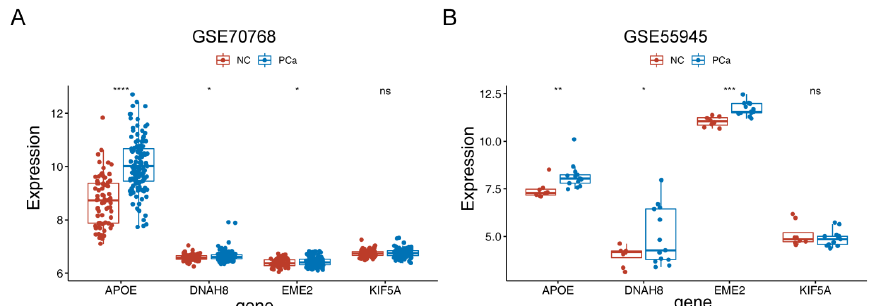
Figure 6. Validation the expression levels of four model genes in the GSE70768 and GSE55945 datasets. ( A ) The expression levels of the four model genes in the GSE70768 dataset. ( B ) The expression levels of the four model genes in the GSE55945 dataset. * p < 0.05, ** p < 0.01, *** p < 0.001, **** p < 0.0001, ns represents no significant difference. 3.8. Validating the Expression of the Four Model Genes by qRT-PCR The expression validation of the four model genes was performed on normal human prostate epithelial cells and PCa cells by qRT-PCR. We found a significantly higher ex- pression of APOE and EME2 in PCa cell line groups compared with RWPE-1. Moreover, DNAH8 expressed significantly higher in PC-3 and DU145 than in RWPE-1, while the ex- pression of DNAH8 was not detected in LNcap lines. However, the expression of KIF5A was distinctly higher in the normal prostate epithelial cell group than in all 3 PCa tissue sample groups, which was contrary to the TCGA result (Table 6, Figure 7). Therefore, APOE , EME2, and DNAH8 could be considered reliable and precise model genes for PCa. Table 6. qRT-PCR Results for the 4 model genes.